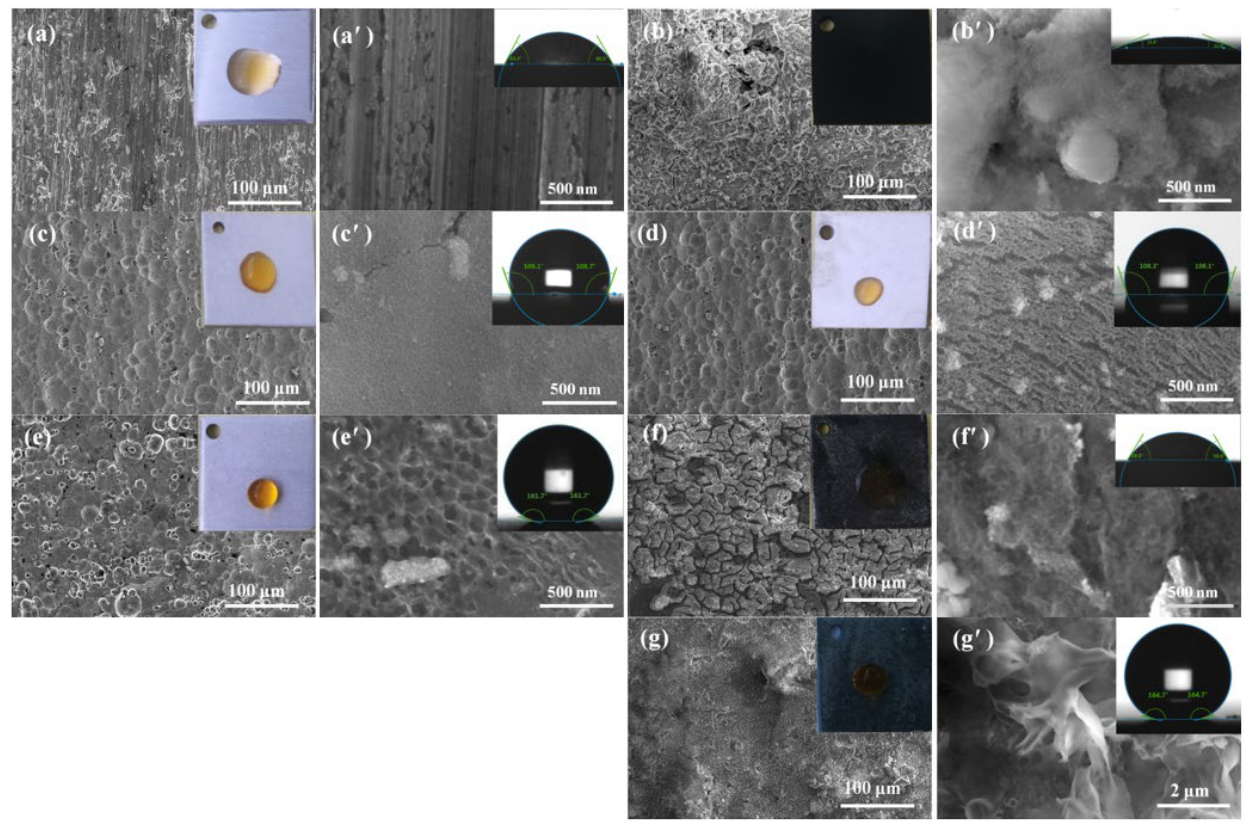
Figure 2. SEM images of ( a,a ′ ) untreated aluminum alloy, (b,b ′ ) NaOH-etched aluminum alloy at 25 °C after HCl washing, ( c,c ′ ) HCl-washed aluminum alloy after Na 2 CO 3 etching, ( d,d ′ ) Na 2 CO 3 -etched aluminum alloy at 25 °C, ( e,e ′ ) stearic-acid-treated aluminum alloy after Na 2 CO 3 etching, ( f,f ′ ) NaOH-etched aluminum alloy at 90 °C and ( g,g ′ ) stearic-acid-treated aluminum alloy after NaOH etching at 90 °C. The inset is the image of the contact angle. Table 2. Static water contact angles for (a) untreated aluminum alloy, (b) NaOH-etched aluminum alloy at 25 °C after HCl washing, (c) HCl-washed aluminum alloy after Na 2 CO 3 etching, (d) Na 2 CO 3 -etched aluminum alloy at 25 °C, (e) stearic-acid-treated aluminum alloy after Na 2 CO 3 etching, (f) NaOH-etched aluminum alloy at 90 °C, (g) stearic-acid-treated aluminum alloy after NaOH etching at 90 °C, (h) stearic-acid-treated sample after Na 2 CO 3 etching after abrasion test and (i) stearic-acid-treated sample after NaOH etching at 90 °C after abrasion test. Samples